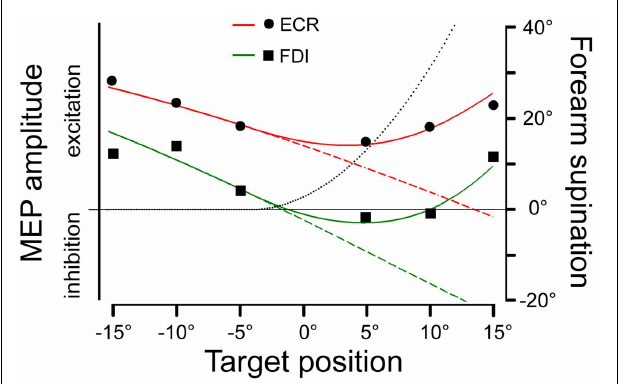
FIGURE 7 | Model predictions of changes in MEP amplitude in the ECR and FDI muscles as a function of saccadic target position. Experimental mean MEP amplitudes in arbitrary units are depicted by dots and squares for the ECR and FDI muscles, respectively. Model predictions are shown by red (ECR) and green (FDI) traces and by varying (continuous lines) or maintaining constant (dashed lines) the angle of forearm supination. The black dotted line illustrates the changes in the forearm supination angle, which predicted the best fitting of the experimental